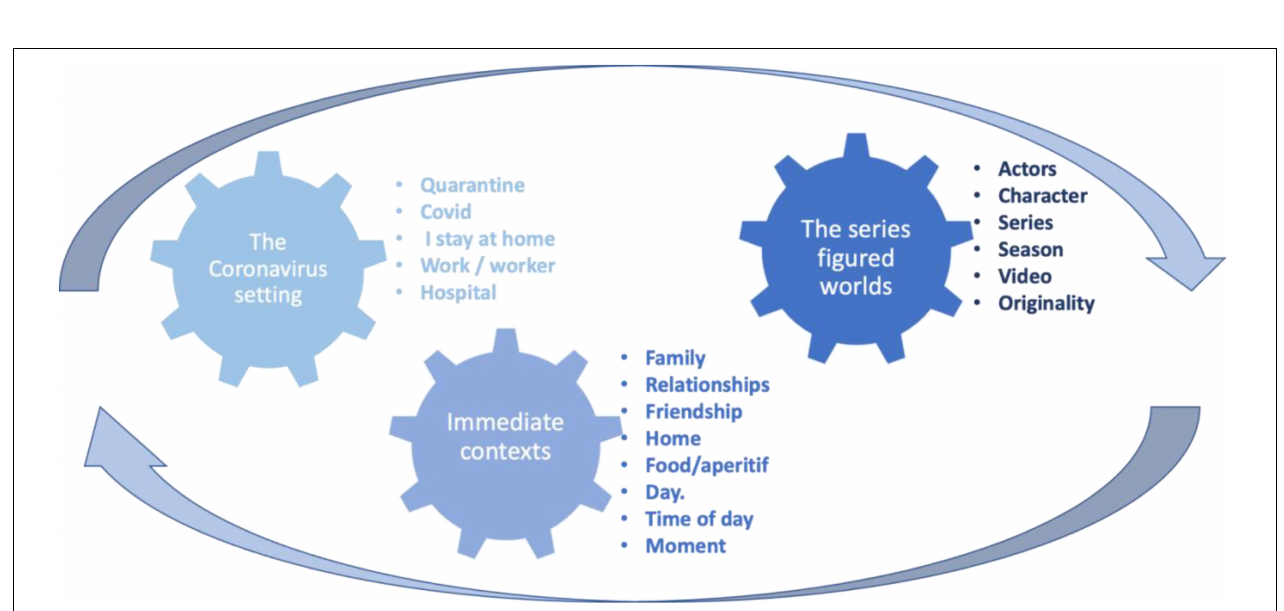
FIGURE 3 | Word cloud. Terms used MOST OFTEN in conversations.